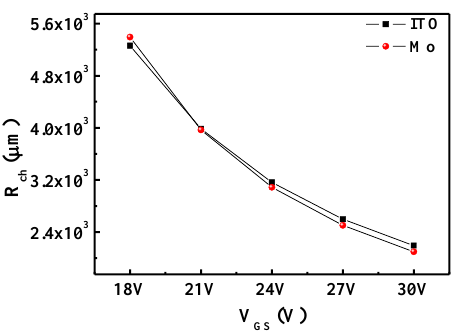
Figure 3. Plot of the channel resistance per unit channel length ( R ch ) of a-STO TFT with ITO and Mo contact as a function of the gate voltage ( V GS ).